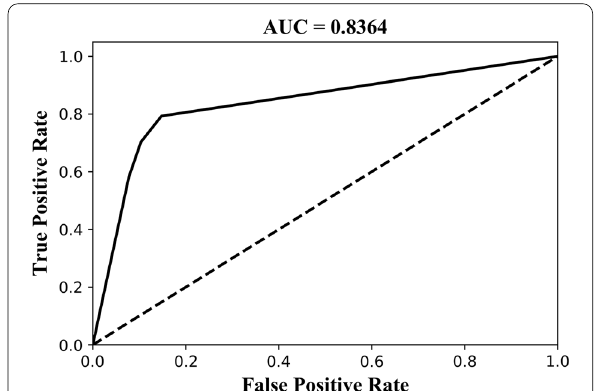
Fig. 6 ROC curve and AUC value obtained by Classifer-inRAC on classifying the testing samples in D3